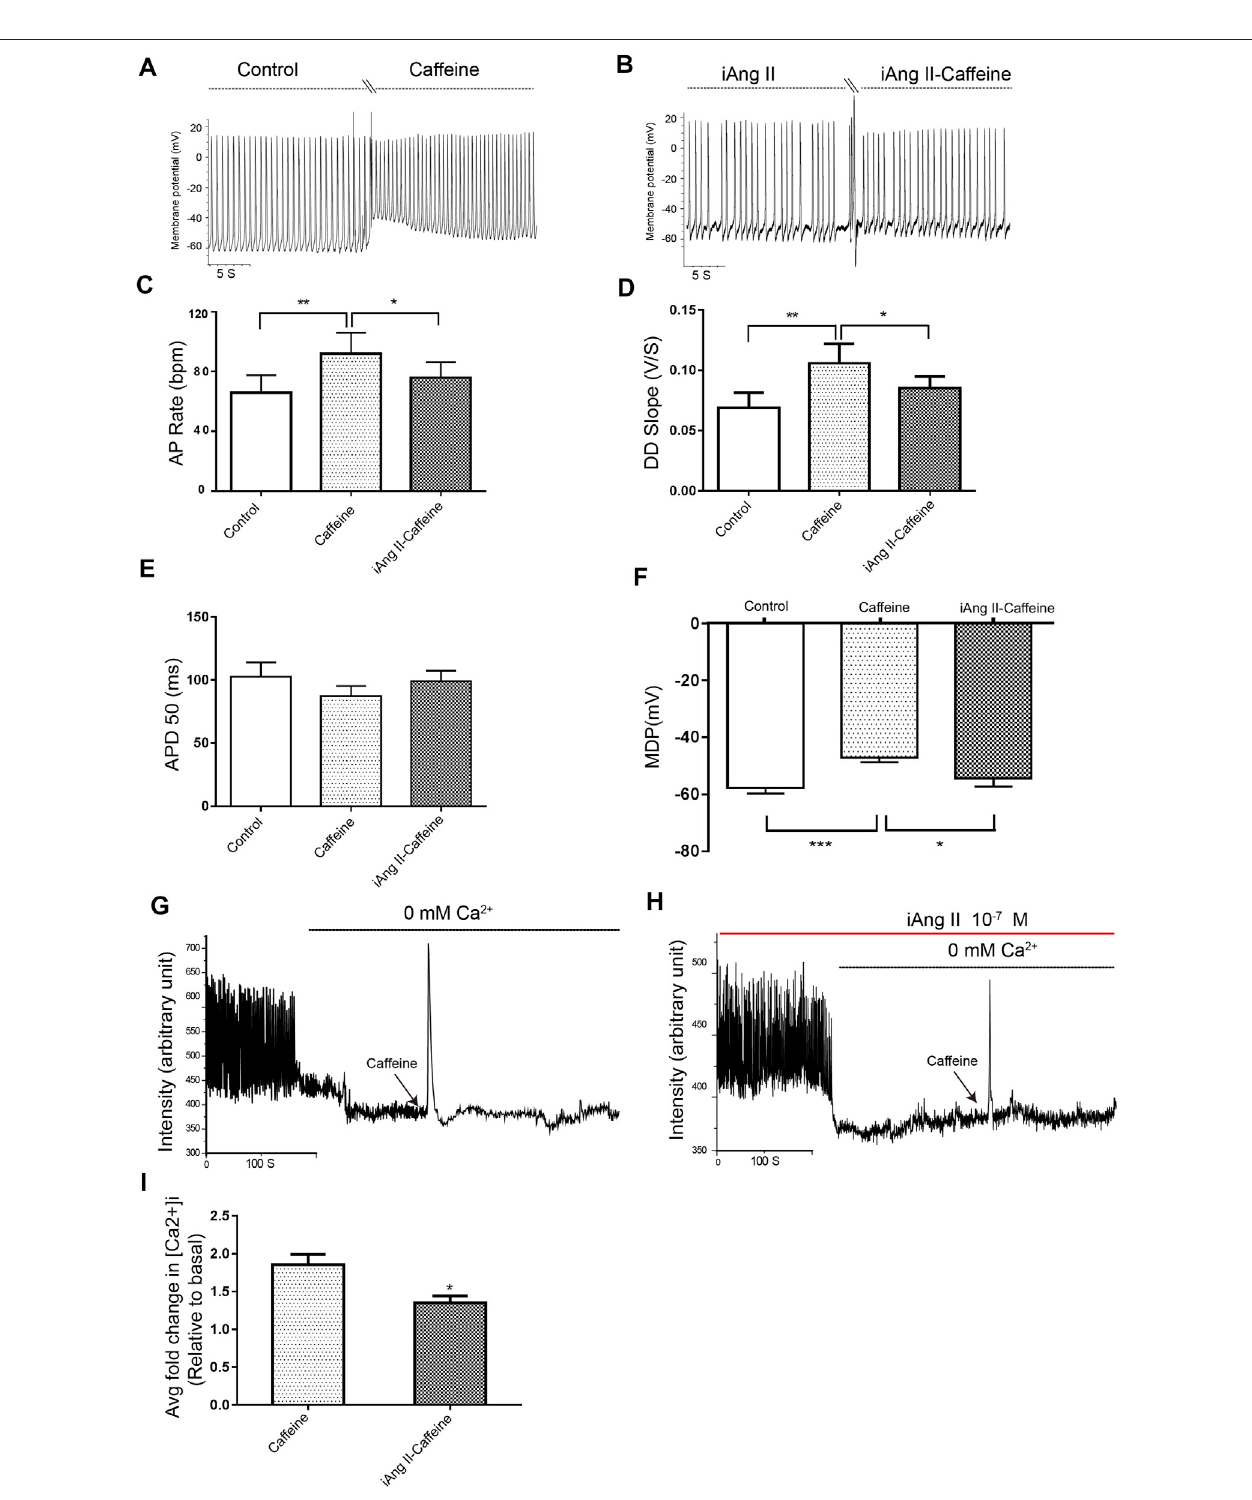
FIGURE6| iAngIIattenuatedcaffeine-inducedchangesofAPsandcaffeine-inducedCa 2+ releaseinmESC-CMs. (A) RawtracesofspontaneousAPsatthebasal level and upon treatment with caffeine (5 μ M) in mESC-CMs. (B) Raw traces of spontaneous APs upon treatment with iAng II (10 – 7 M) followed by the subsequent application of caffeine in mESC-CMs. (C – F) Summarized data on the (C) AP rate, (D) DD slope, (E) APD50, and (F) MDP upon treatment with caffeine (5 μ M) alone or upon treatment with iAng II (10 – 7 M) followed by caffeine (5 μ M). (G) Raw traces of changes in Fluo-4 fl uorescence at the basal level and upon treatment with caffeine (5 μ M) in mESC-CMs. (H) Raw traces of changes in Fluo-4 fl uorescence with caffeine in the presence of iAng II (10 – 7 M) in mESC-CMs. (I) Summarized data on the effects of iAng II (10 – 7 M) on the caffeine-induced Ca 2+ release in mESC-CMs when external Ca 2+ was absent. Values are mean ± SEM of 6 – 10 independent experiments. * p < 0.05 vs. control